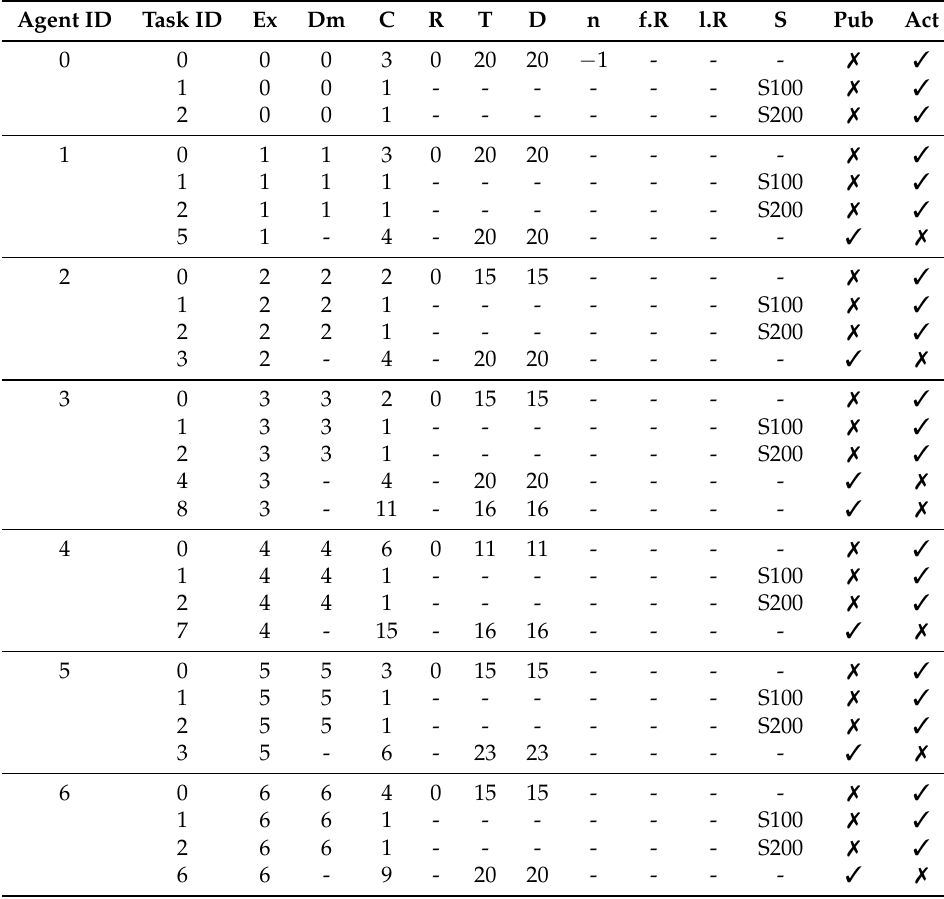
Table 8. Agents’ task-set for Scenario S3rt.